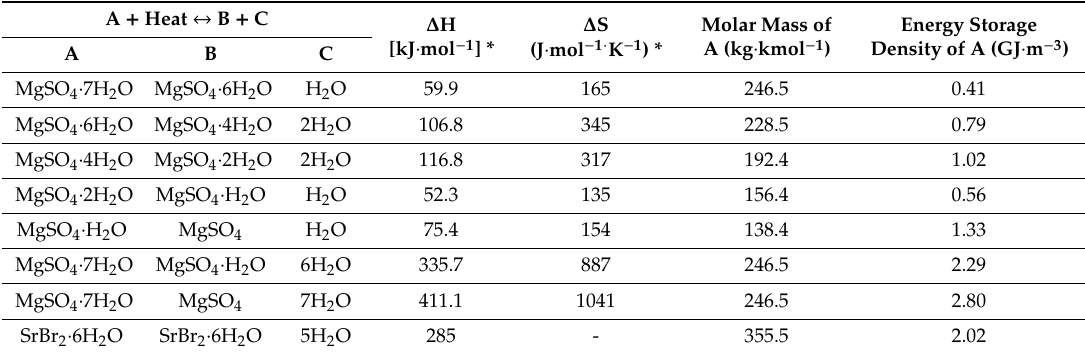
Table 2. Properties of several dehydration steps of hydrates of magnesium sulphate [48] and strontium bromide [49].